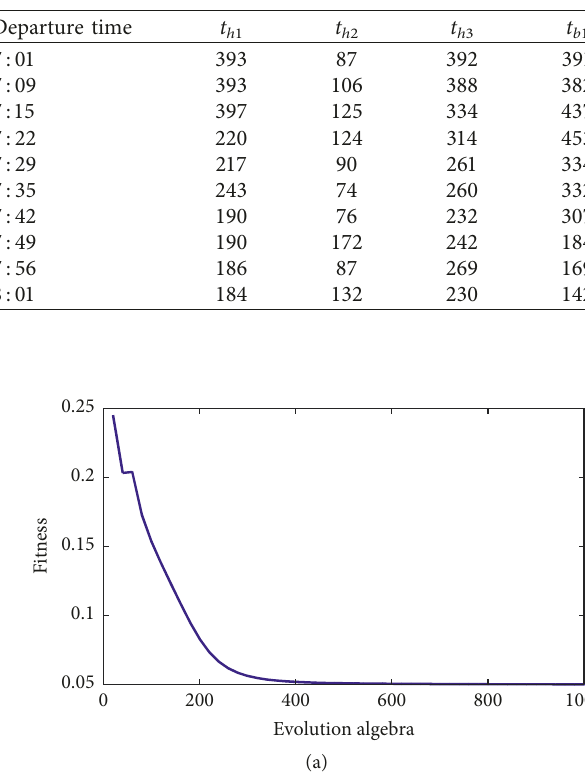
Table 1: Part of the training sample